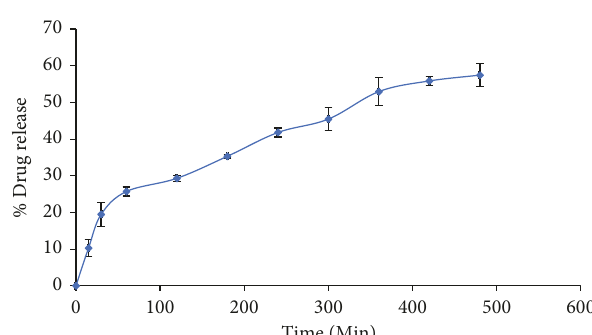
Figure 10: Ex vivo release data of microneedle